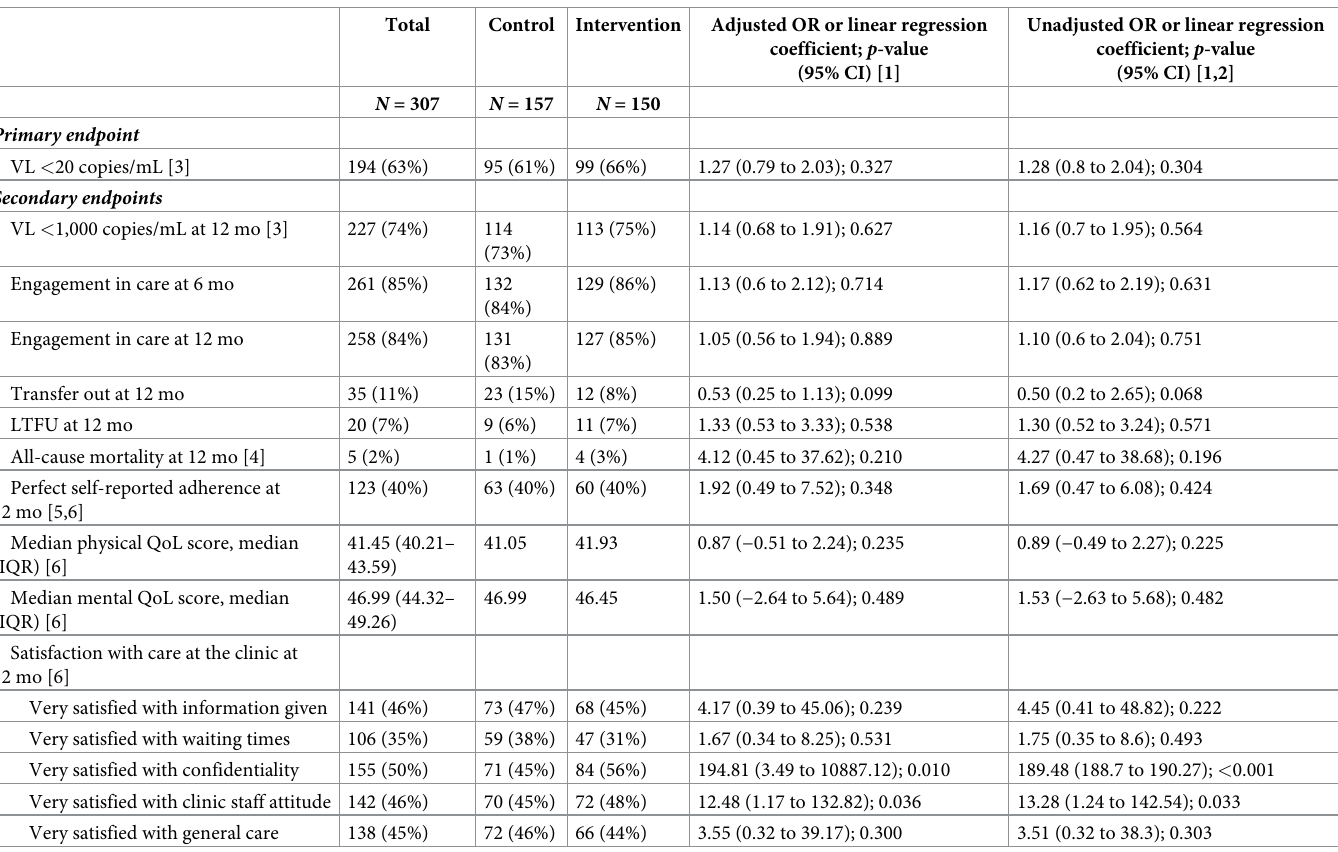
Table 2. Primary and secondary